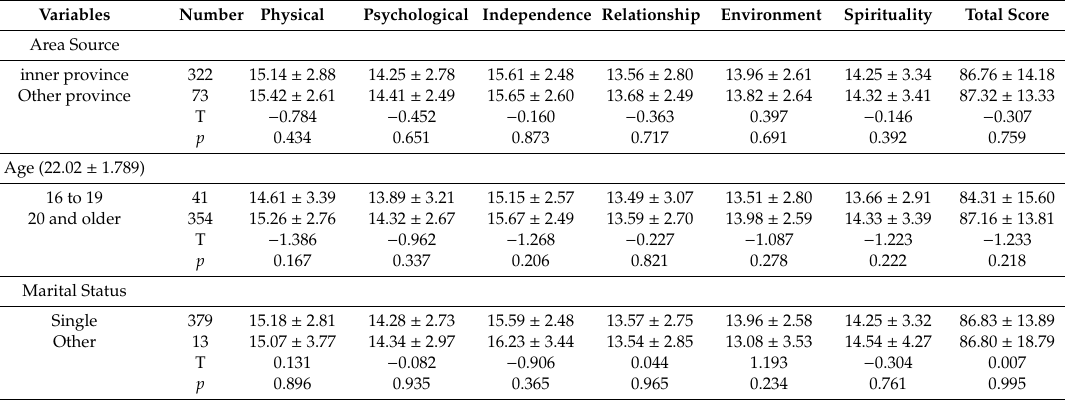
Table 2. Sociodemographic characteristics and relationships with all domains of quality of life for all